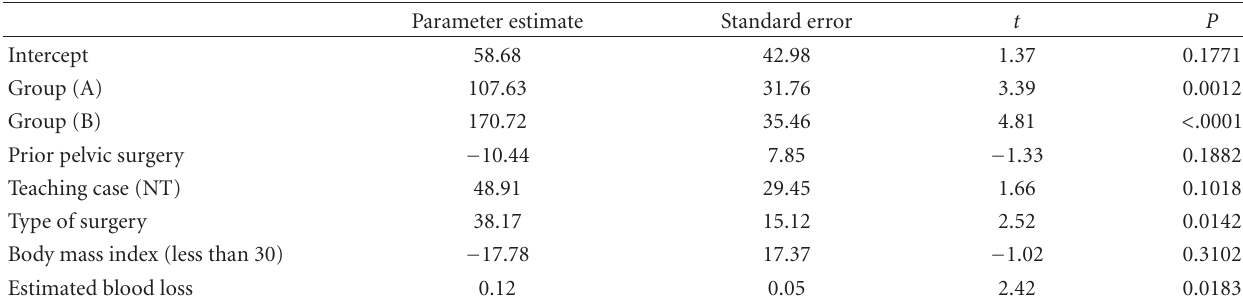
Table 3: Regression model: the e ff ects of preoperative characteristics on operative